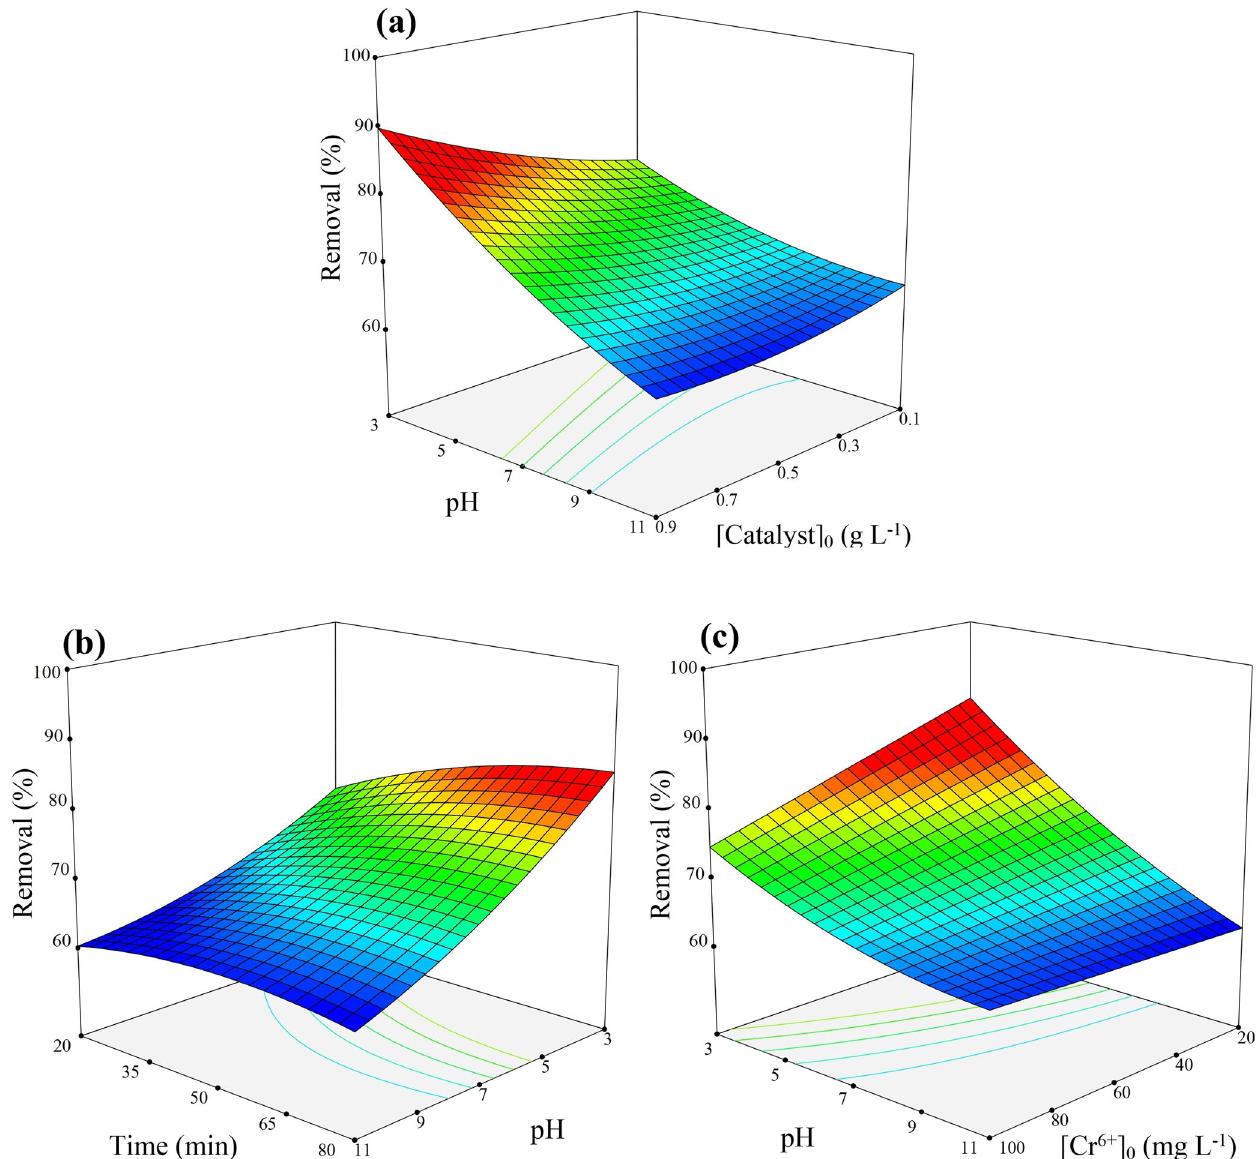
Fig. 6 Response surface plots of the Cr 6 + removal ef fi ciency. a pH-catalyst dosage. b pH-irradiation time. c pH-initial Cr 6 +